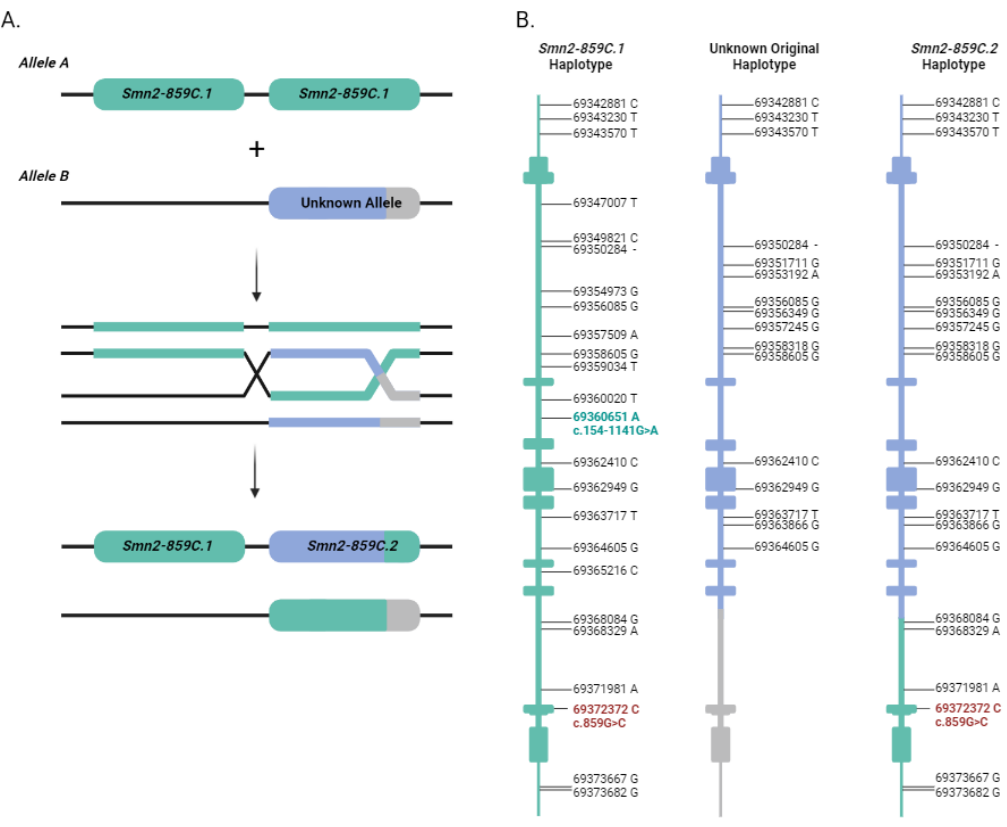
Figure 3. Proposed mechanism of origin and structure of Smn2-859C.1 and Smn2-859C.2 haplotypes. ( A ) Hypothetic origin of the Smn2-859C.2 haplotype through homologous recombination involving a double cross-over event between allele A (with two Smn2-859C.1 haplotypes represented in green) and allele B (containing the 5′ region of the Smn2-859C.2 haplotype, in blue, and the 3’ end with an unknown sequence, in grey). ( B ) SMN2 structure details (representing exons and introns from top to bottom) and location of variants of the Smn2-859C.1 and Smn2-859C.2 haplotypes, as well as the unknown original haplotype that presumably originated the Smn2-859C.2 haplotype. The c.154-1141G>A (69360651-G-A, hg19/GRCh37) variant is indicated in green, whereas the c.859G>C modifier is shown in red (further explanation in the text and Table 2).